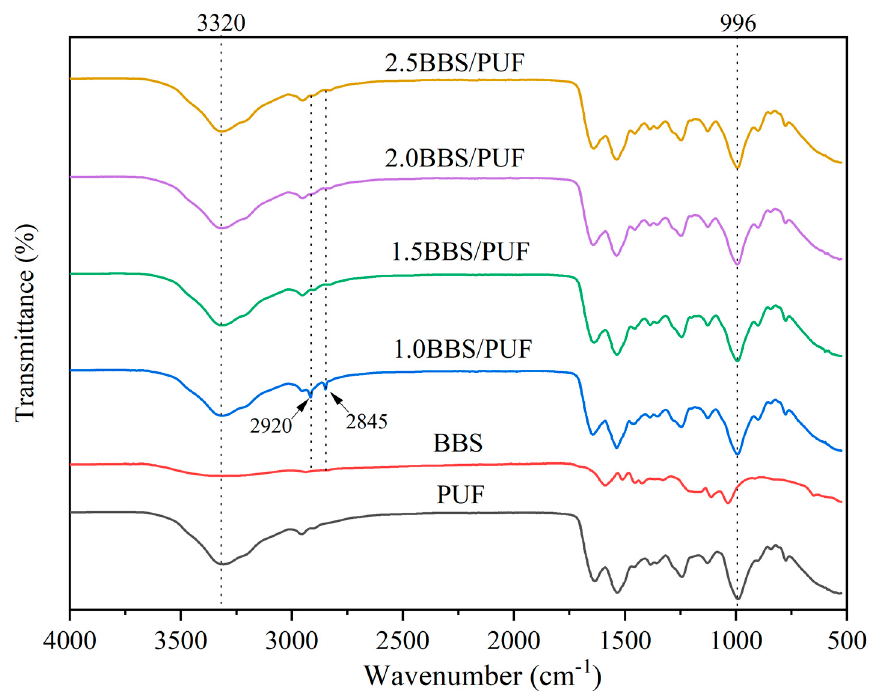
Figure 2. FTIR spectra of BBS, PUF, and BBS ‐ modified PUF resins in the region of 500–4000 cm − 1